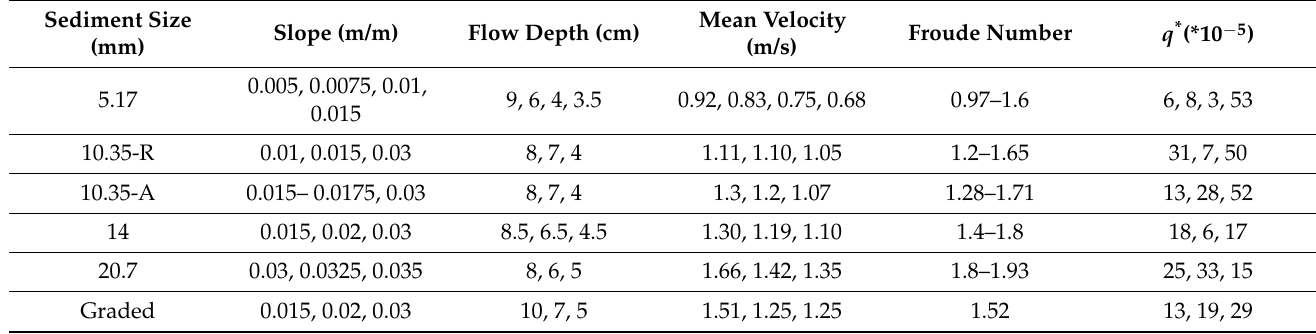
Table 2. Range of hydraulic conditions and sediment transport